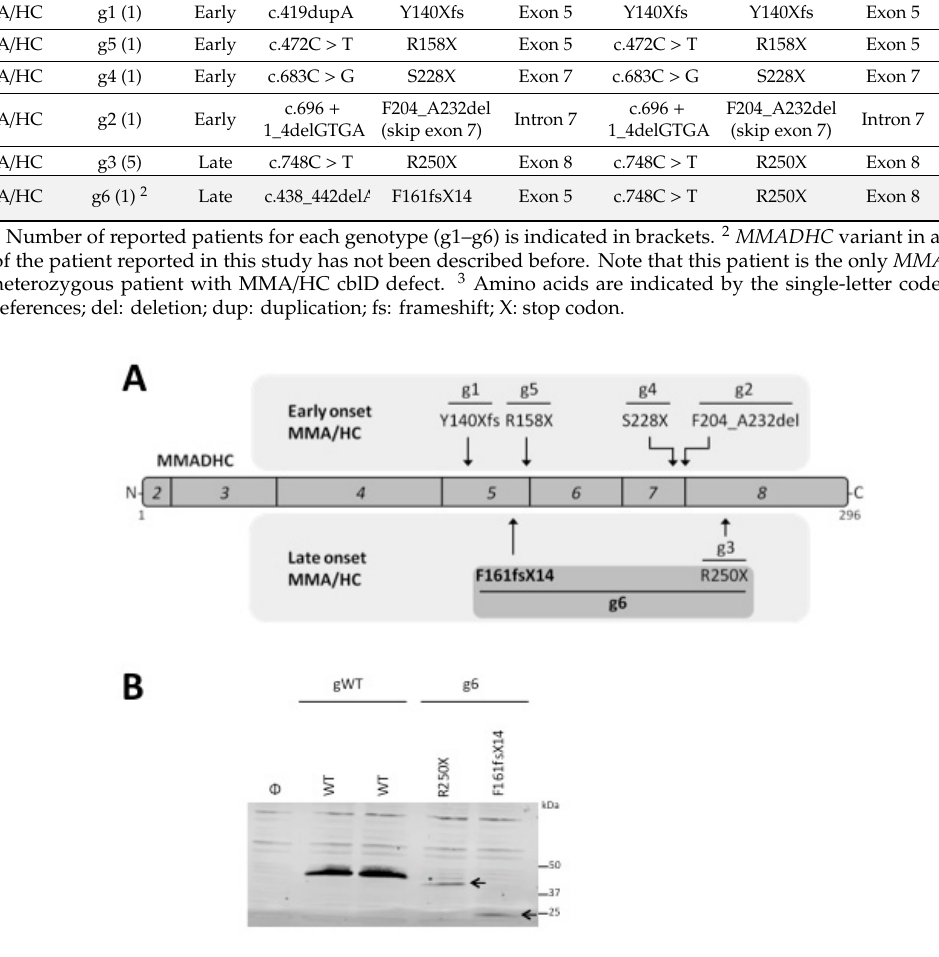
Figure 1. Genotype and protein dysfunction in combined Cobalamin D disorder: ( a ) Schematic depiction of the distinct MMADHC protein alterations and associated genotypes in patients with combined cblD defect. Exons (2 to 8, in italics) encoding MMADHC protein (amino acid 1 to 296, from N-terminus (N) to C-terminus(C)) are indicated. Protein alterations that result from MMADHC mutations causing early onset methylmalonic aciduria and homocystinuria (MMA/HC) (top) or late-onset MMA/HC (bottom) are shown, with an indication of the associated genotype (g1 to g6; see Table 2 for details). Note that g1 to g5 are homozygous genotypes for each mutation, whereas g6 (this study) is a heterozygous compound genotype that includes the novel allelic variant encoding F161fsX14 in combination with the allelic variant encoding R250X. Amino acids are indicated by the single-letter code; X, stop codon; fs, frameshift; del, deletion; ( b ) MMADHC recombinant protein variants from genotype WT (gWT) and genotype F161fsX14/R250X (g6). COS-7 cells were transfected with empty vector ( Φ , control), or with plasmids containing the indicated HA- MMADHC variants, and cell lysates were resolved by SDS-PAGE under reducing conditions, followed by immunoblot using anti-HA (hemagglutinin) antibody. Arrows indicate the bands corresponding to the MMADHC protein variants R250X and F161fsX14.